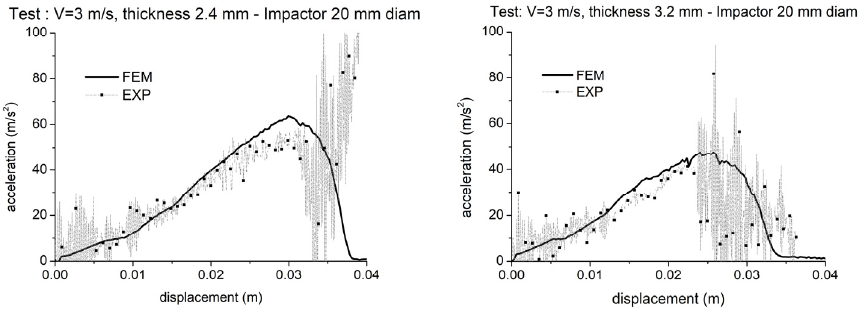
Figure 6. Force—displacement curves measured using the 20 mm-diameter hemispherical impactors: impact speed 3 m/s, nominal part thickness 2.4 mm ( left ) and 3.2 mm ( right ).